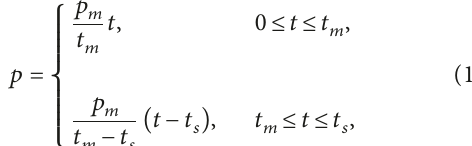
Figure 2: Approximate yield curve of the